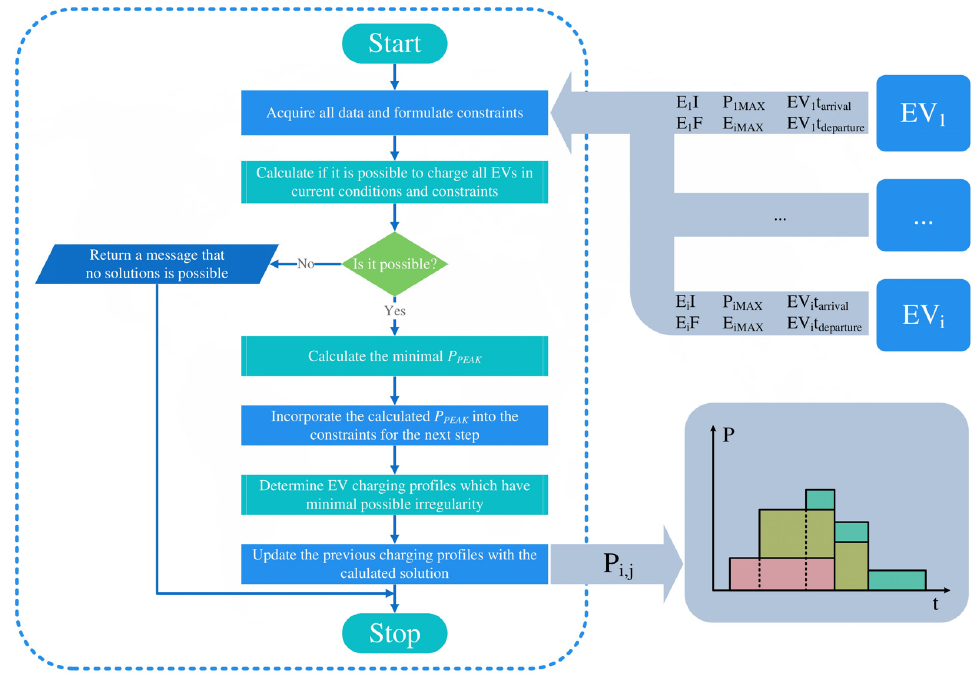
Figure 2. Flowchart of the proposed EV coordination algorithm.